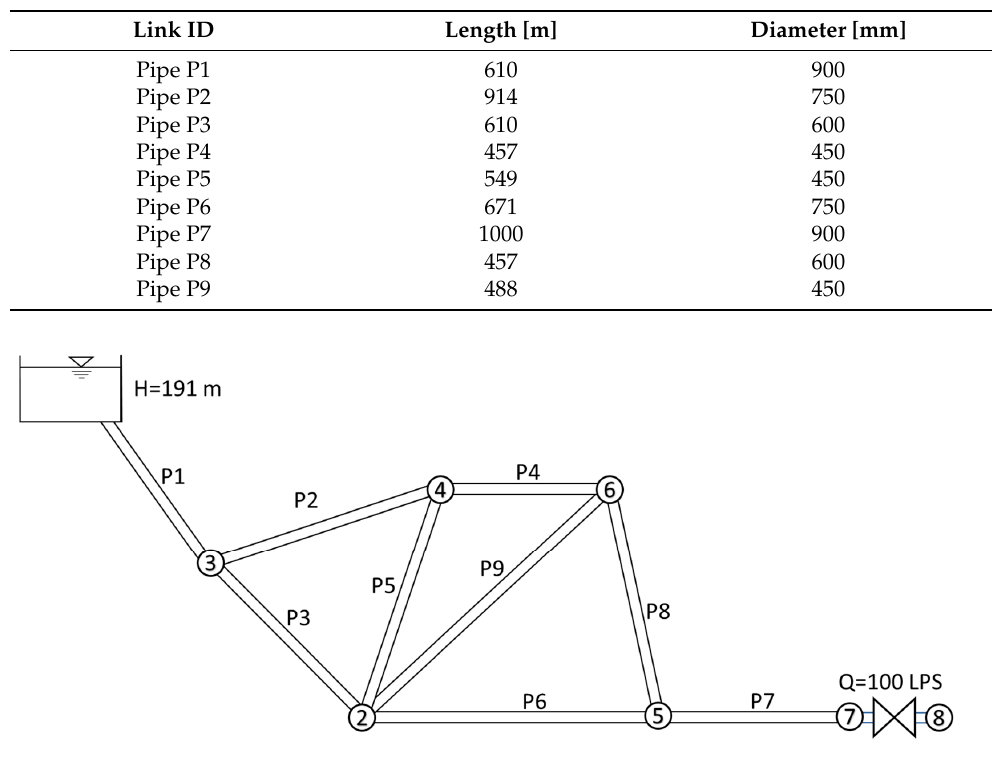
Figure 6. The layout of the second case study, depicting a looped network system with a single source and a consumer at the downstream. and a consumer at the